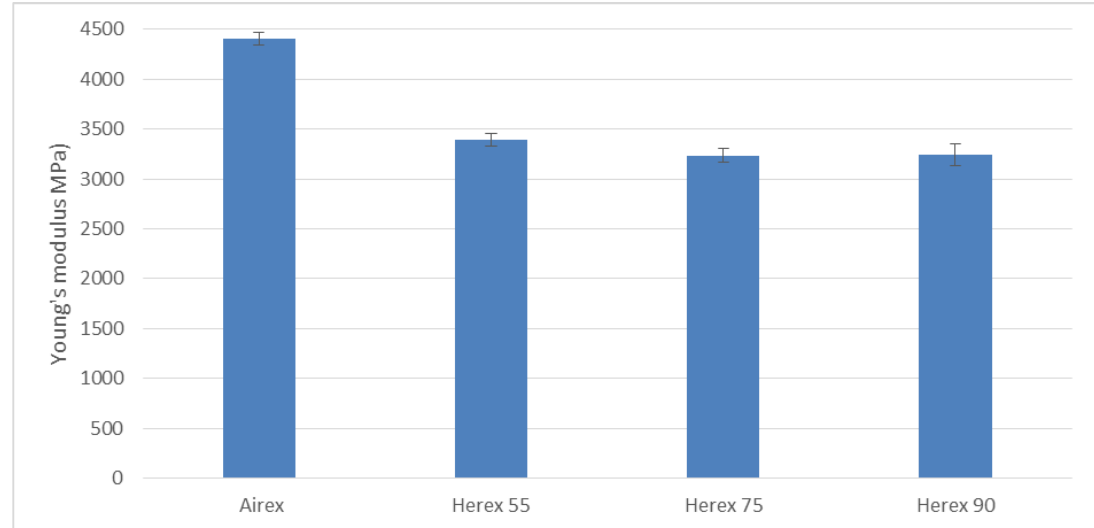
Figure 19. Young’s modulus during tension of the tested composites.